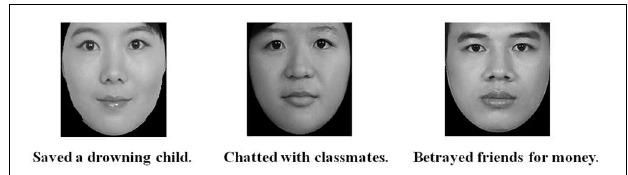
FIGURE 1 | Examples of experiment